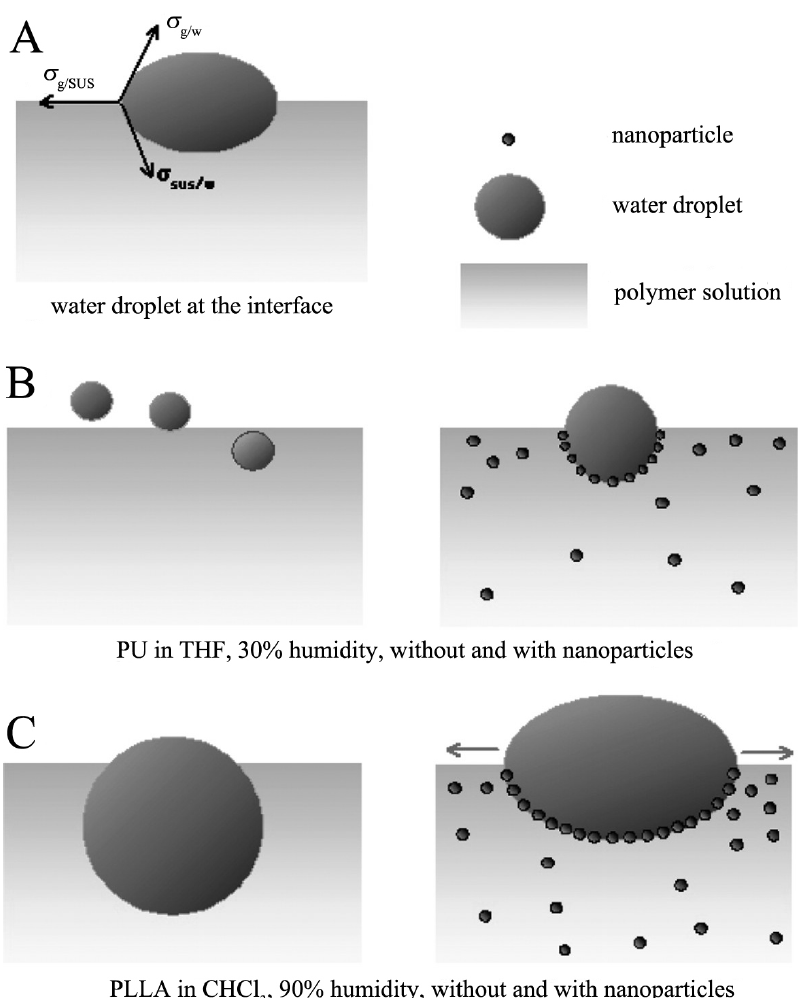
Figure 14. Schematic diagram of a water droplet at the air/solution interface with or without Ag nanoparticle stabilization during breath figure process. PU and PLLA are polyurethane and poly(L-lactic acid), respectively. ( A ) Wetting behavior of the water droplet at the solution-air interface. ( B ) PU in THF with 30% humidity, the water droplets sink into solution without the stabilization of Ag nanoparticles (left), while the water droplets spread stable at the solution-air interface with the stabilization of Ag nanoparticles (right). ( C ) PLLA in CHCl 3 with 90% humidity, the water droplet grows fast to a large volume and immerses deeply into the polymer solution (left), resulting in the irregular pore pattern. And with the addition of Ag nanoparticles, the water droplet spreads at the solution-air interface stably with more surface exposed to air (right). The copyright permission was from